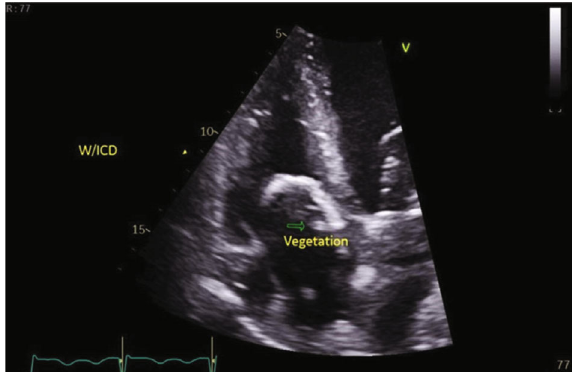
Figure 1: Vegetationson top of ICD lead. Transthoracic echocardiography, apical four-chamber view showing a large vegetation on the top of ICD atrial lead in a case of brucella